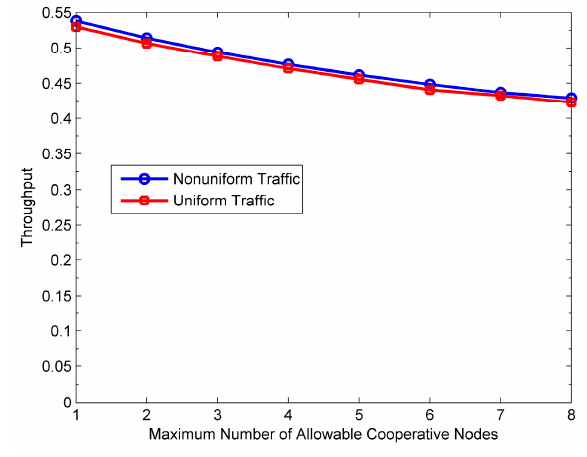
Figure 19. Throughput vs. M .